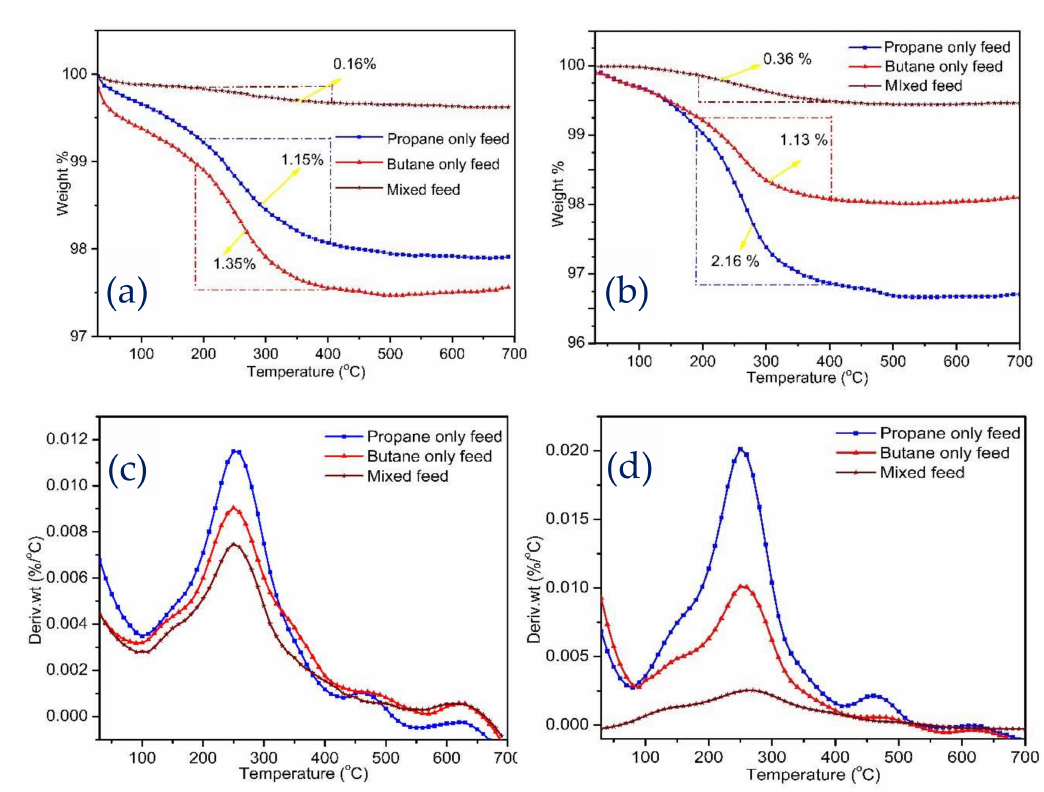
Figure 8. Thermogravimetric profiles of deactivated catalysts under oxygen atmosphere: ( a ) NaBH 4 reduced catalyst and ( b ) H 2 reduced catalyst, Di ff erential thermal analyses of deactivated catalysts under oxygen atmosphere ( c ) NaBH 4 reduced catalyst and ( d ) H 2 reduced